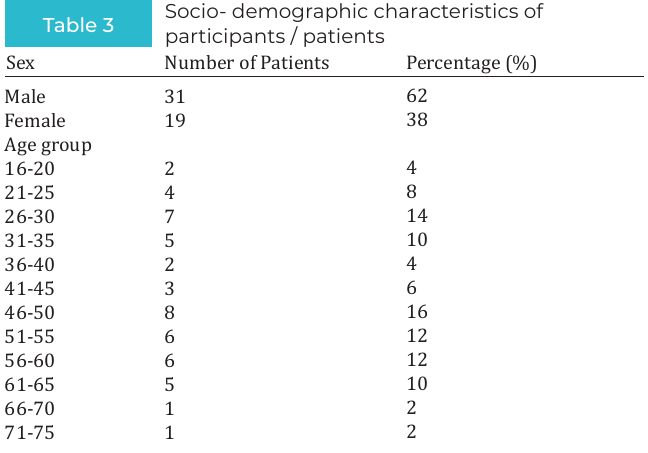
Socio- demographic characteristics of participants / patients